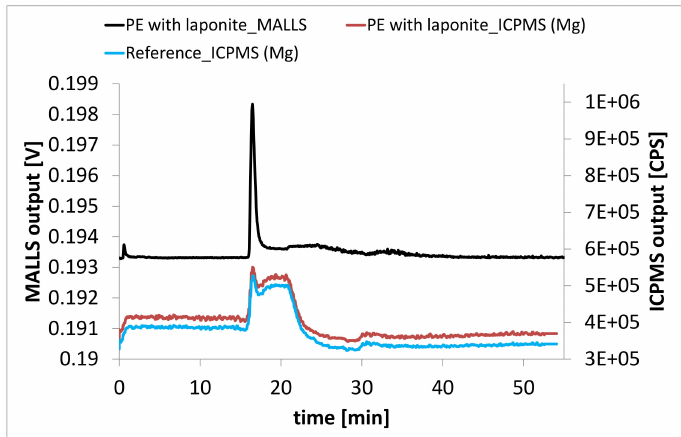
Figure 9. AF4/MALLS/ICP-MS fractograms of a test sample that was stretched first and then abraded: The same sample that caused a signal via MALLS detection (black) at elution times relevant for laponite did not cause a signal for Mg via ICP-MS (online) detection (red). Via AF4/ICP-MS detection no difference between abrasion from test samples and the reference sample withoutlaponite (blue, shifted by − 2.5 × 10 4 CPS for better differentiation) could be